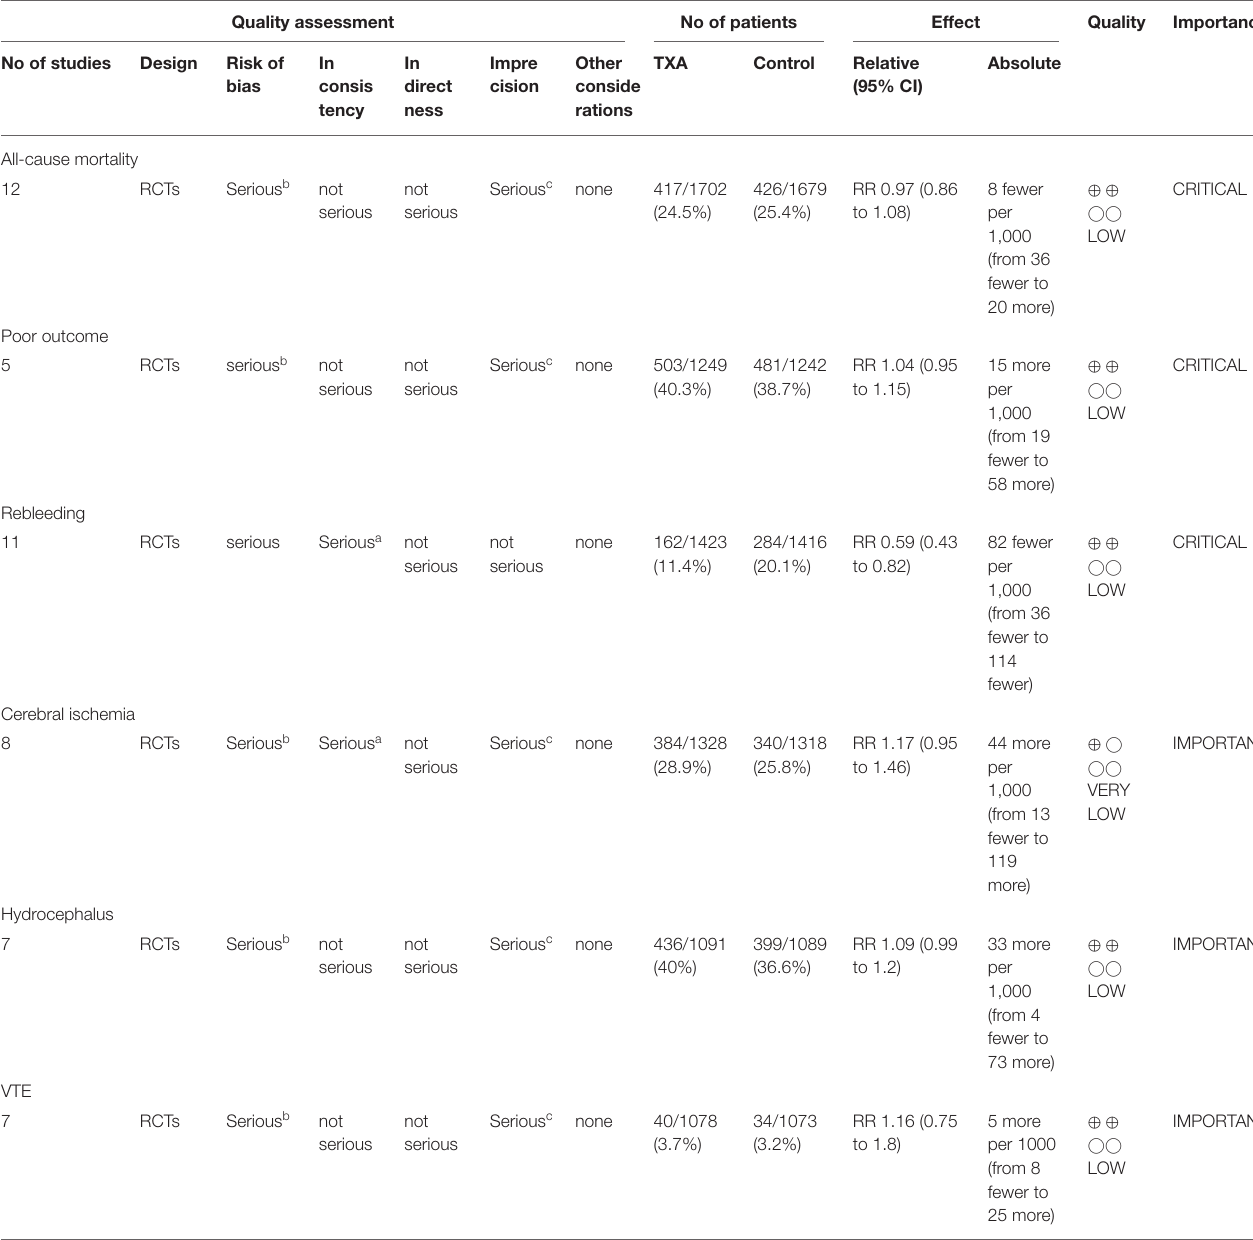
TABLE 2 | GRADE summary of quality of evidence for primary outcomes: tranexamic acid vs. control treatment in aneurysmal subarachnoid hemorrhage. Quality